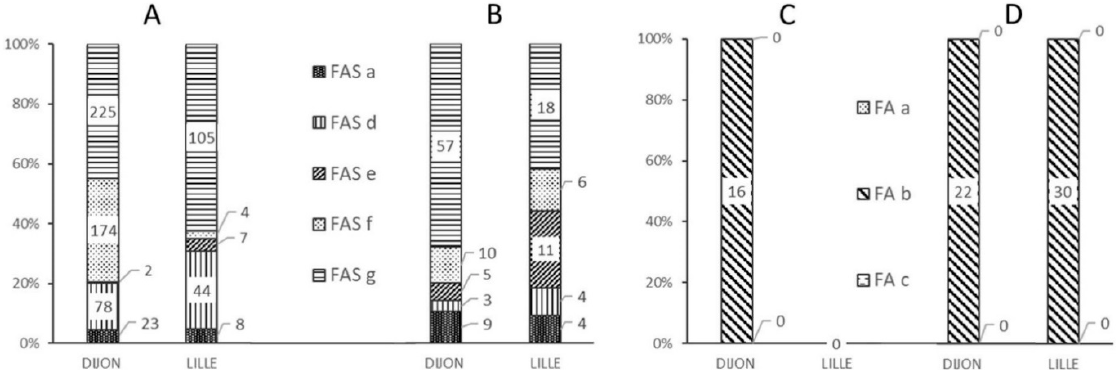
Figure 3. Frequency of different alerts as a function of the analysis center and the MALDI-MS classification of the spectrum. ( A ) Alerts for “standard” FAS MALDI spectra, ( B ) Alerts for “non-standard” FAS MALDI spectra, ( C ) Alerts for misclassified “standard” FA MALDI spectra, ( D ) Alerts for misclassified “non-standard” FA MALDI spectra.